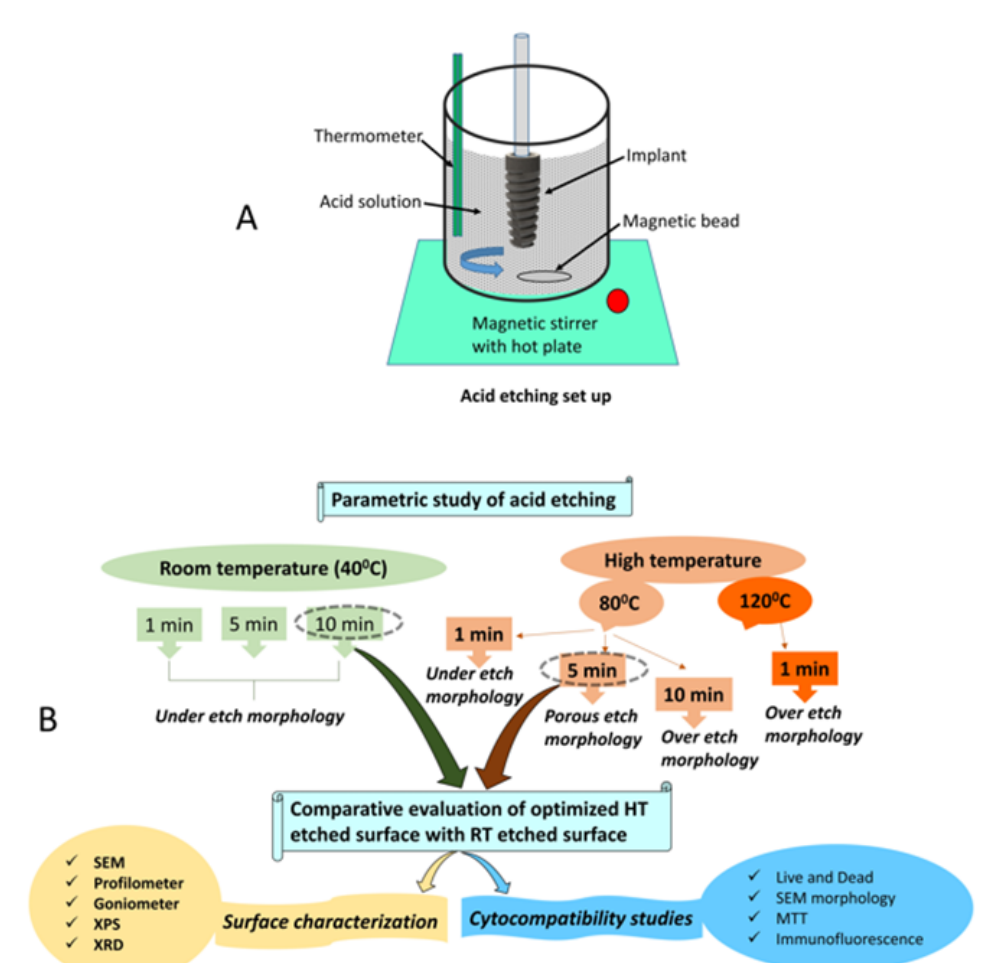
Figure 2. ( A ) Acid etching set- up. ( B ) Schematics representing the outline of the study and showing acid etching parameters, characterization methods, and cytocompatibility studies.